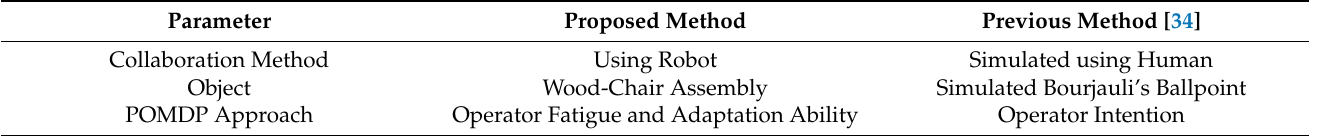
Table 2. Main Comparison